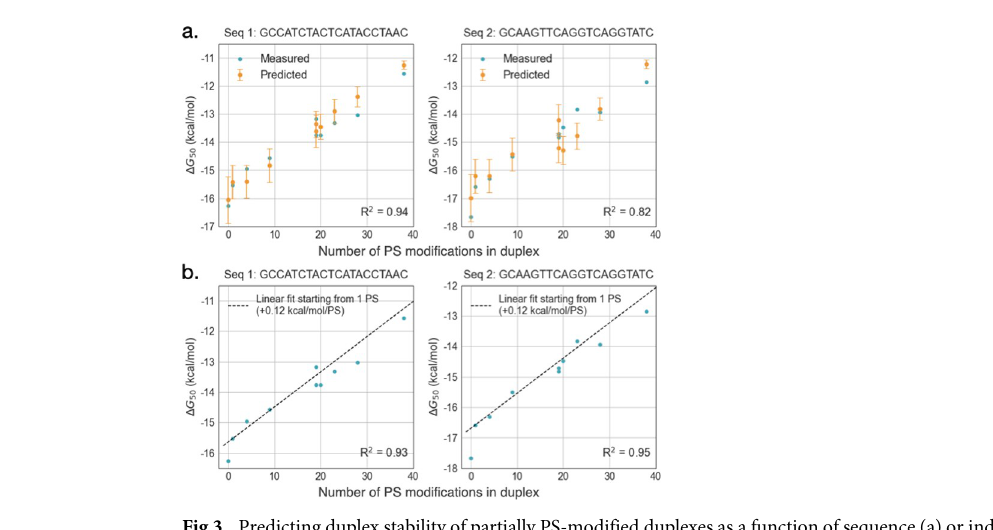
Fig 3. Predicting duplex stability of partially PS-modified duplexes as a function of sequence (a) or independently of sequence (b). (a) Duplexes with partially-modified strands were considered as a linear combination of PO-PO (symmetrical), PS-PO (asymmetrical), and/or PS-PS (symmetrical) nucleotide pairs and Δ G parameters of these pairs across the three backbone conditions were used to predict the overall duplex stability. Errors are calculated using the variances of the parameter estimates. (b) Data from fully PS-PO or PS-PS duplexes was used to determine the average energetic contribution of a single PS backbone (0.12 kcal/mol/PS). PO-PO duplexes (points at x = 0) are not included in the R 2 shown for sequence-independent predictions due to the large gap in Δ G 50 between x = 0 and x = 1 seen in both sequences tested. Positions of PS linkages in the included duplexes are shown in S2 Table in S1 File .